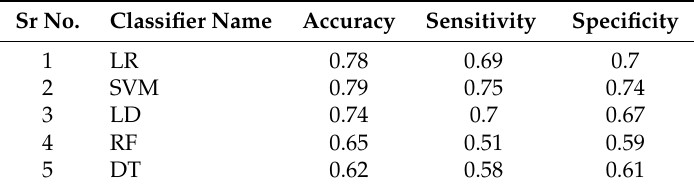
Table 6. 10-Fold Results based on the Top 500 Selected Features based on Proposed 3-Stage Approach. Sr No.